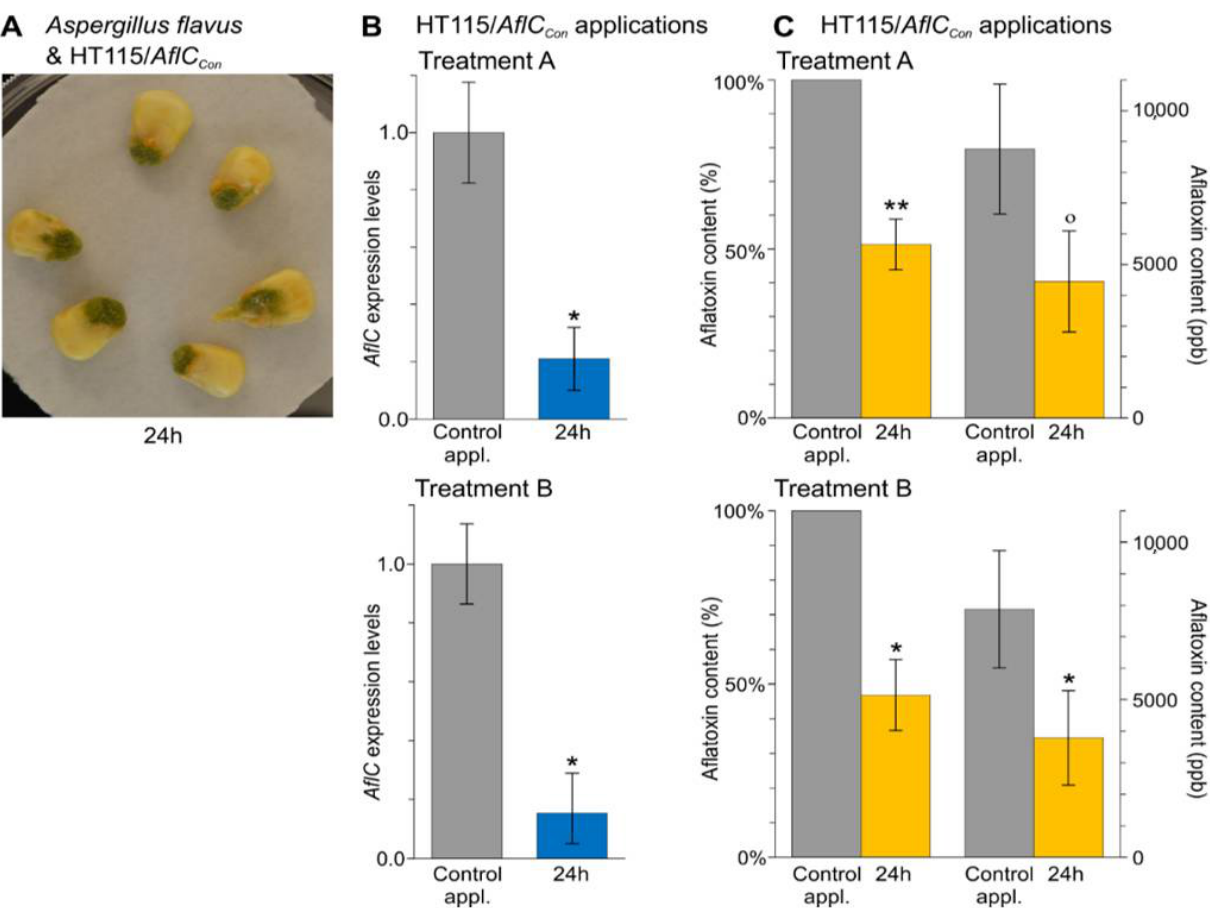
Figure 4. The HT115/ AflC Con strain induces RNAi in A. flavus and a reduction in production of aflatoxins under in vivo conditions. ( A ) A. flavus inoculations on maize kernels. Spores of the fungus were spot inoculated on maize kernels and 48 h later, 10 µ L of the living bacteria or of their whole-cell autolysates, obtained from the OD 600 1.0 culture, were applied to the same inoculation spot. All measurements were taken 24 h later. ( B , C ) AflC expression levels (Panel B) and the amount of aflatoxins produced by A. flavus in vivo on maize kernels (Panel C), following its exposure to living (Treatment A) or lysed (Treatment B) E. coli HT115(DE3) bacteria producing dsRNAs against AflC (HT115/ AflC Con ; test application) or eGFP (HT115/ eGFP Con ; control application). In Panel B, the expression level of AflC in the test applications (blue bars) is shown relative to the control applications (grey bars, set to 1.0). In Panel C, charts on the left-hand side show the mean relative aflatoxins content in the maize kernels in the test (yellow bars) relative to the control applications (grey bars, set to 100%) and, on the right-hand side, the actual amount of aflatoxins (in ppb) in the test and the control applications. Error bars in Panels B and C indicate standard deviations (SD) obtained from at least three biological replicates. Significant differences in gene expression and the absolute amount of aflatoxins between control and test applications were determined by a one-way ANOVA followed by a Tukey’s HSD test. Significant differences in the mean relative aflatoxins content were determined by one-sample t -test. Levels of significance are indicated above the bars by underlined star symbols (i.e., o p < 0.1, * p < 0.05, ** p <